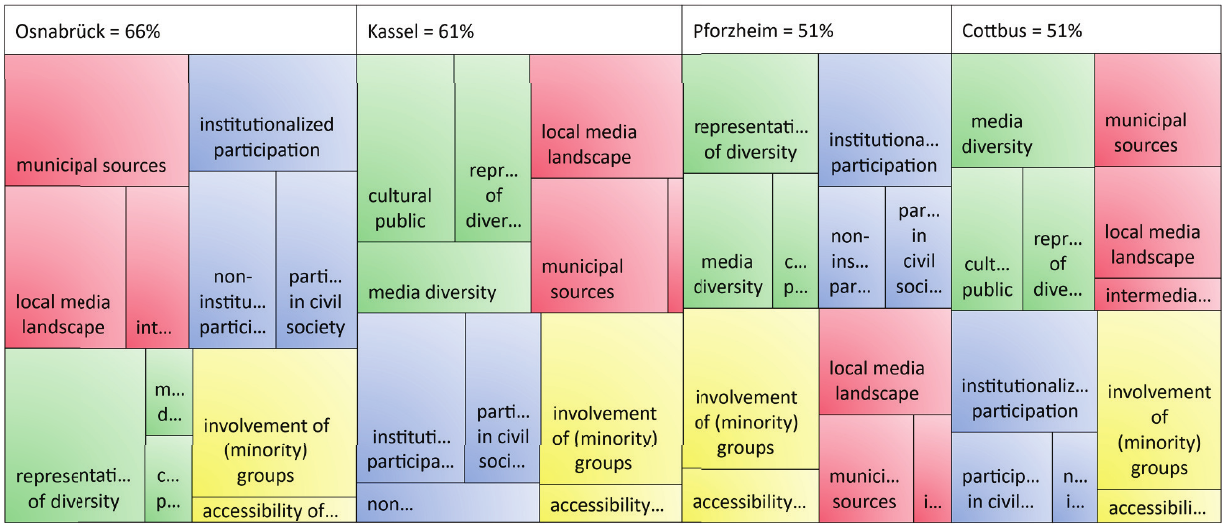
Figure 3. Four cities: Four distinct ‘profiles’ of the local public sphere. Note: The size and order of the rectangles represent the score in the respective